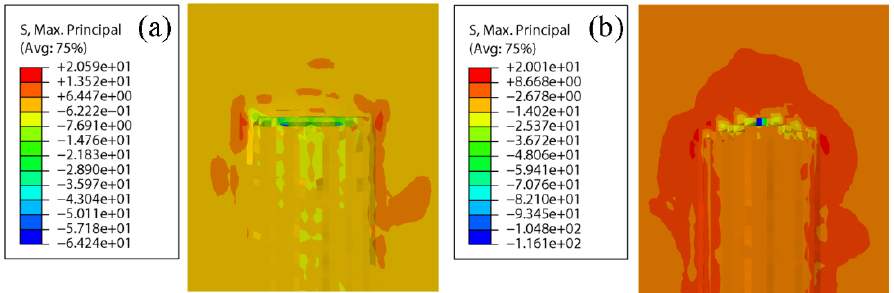
Figure 11. Major Principal Stress in rock-cutting process: ( a ) Conventional cutter; ( b ) 3-RDE cutter.